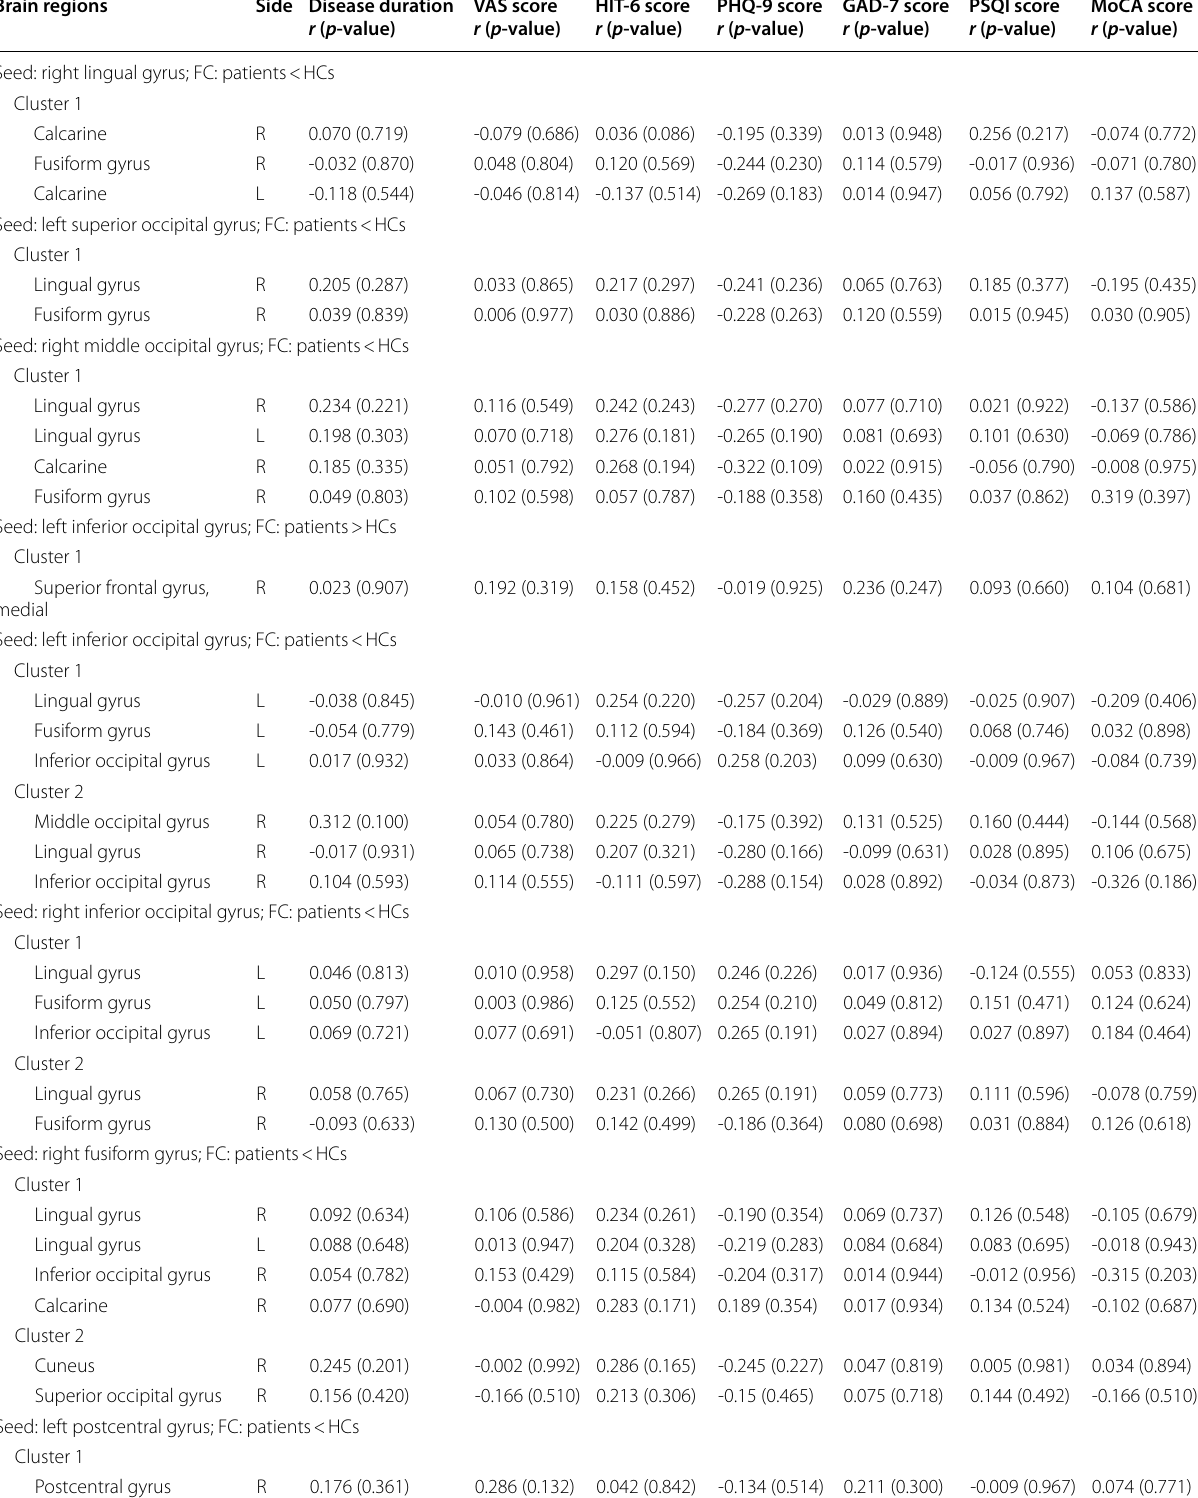
Table 3 The correlation between FC and clinical characteristics in patients with NDPH Brain regions Seed: right lingual gyrus; FC: patients <